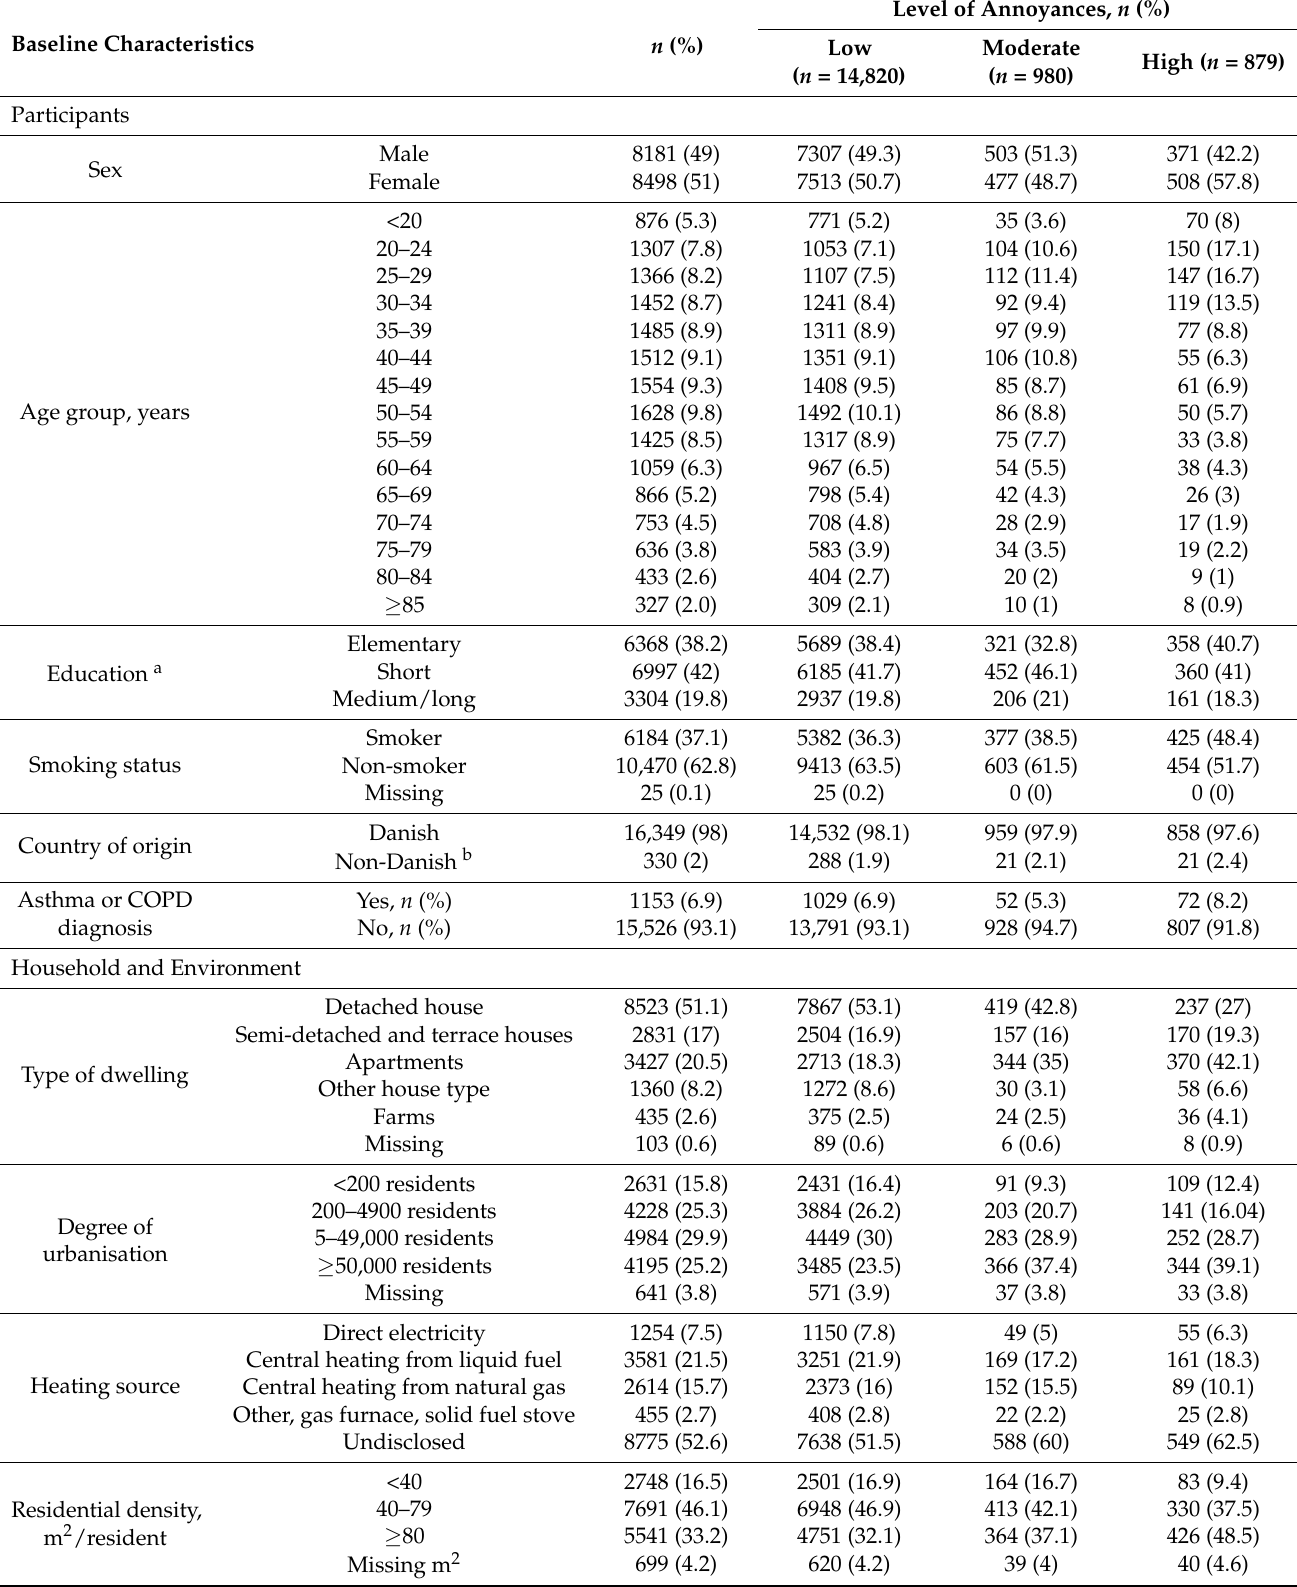
Table 1. Baseline characteristics of participants (total n = 16,679) and their dwellings by level of perceived annoyances in the indoor environment. Values are numbers and percentage in